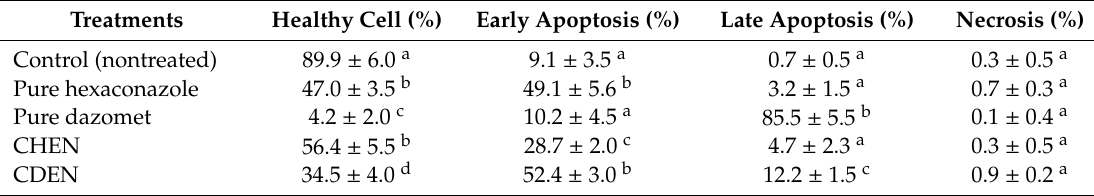
Table 4. Flow cytometry analysis of cellular death using FITC-Annexin V / PI apoptosis detection at 48 h of incubation, where di ff erent letters (a, b, c) in the same column indicate significant di ff erences between means ( p ≤ 0.05) according to Tukey’s test; the values after ± represent the standard deviation of the